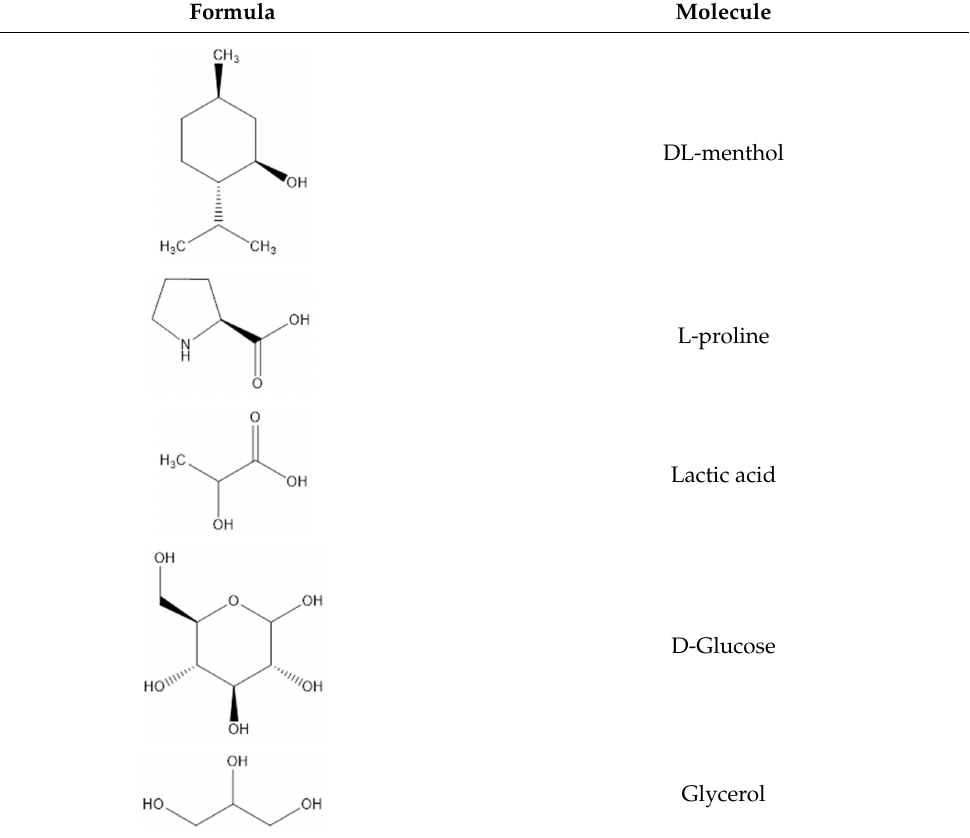
Table 3. Formula of the molecules used in the composition of synthesized NaDES.